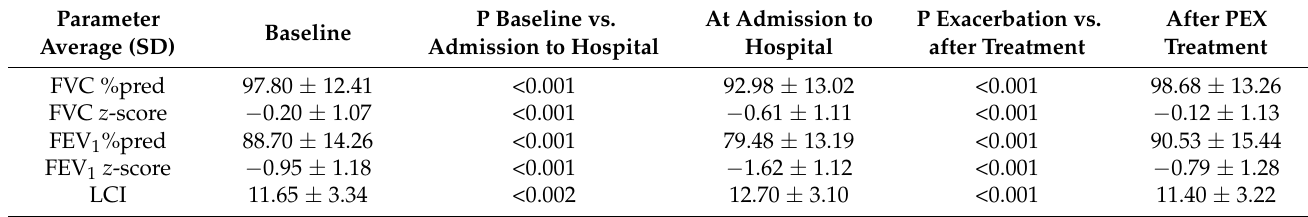
Figure 3. FEV 1 and LCI change between the start and end of PEx treatment. Table 2. Lung clearance index (LCI), forced expiratory volume in 1 s (FEV 1 ), and forced vital capacity (FVC) values during the stable condition, at hospital admission, and after pulmonary exacerbation (PEx) treatment for the study population ( n = 40